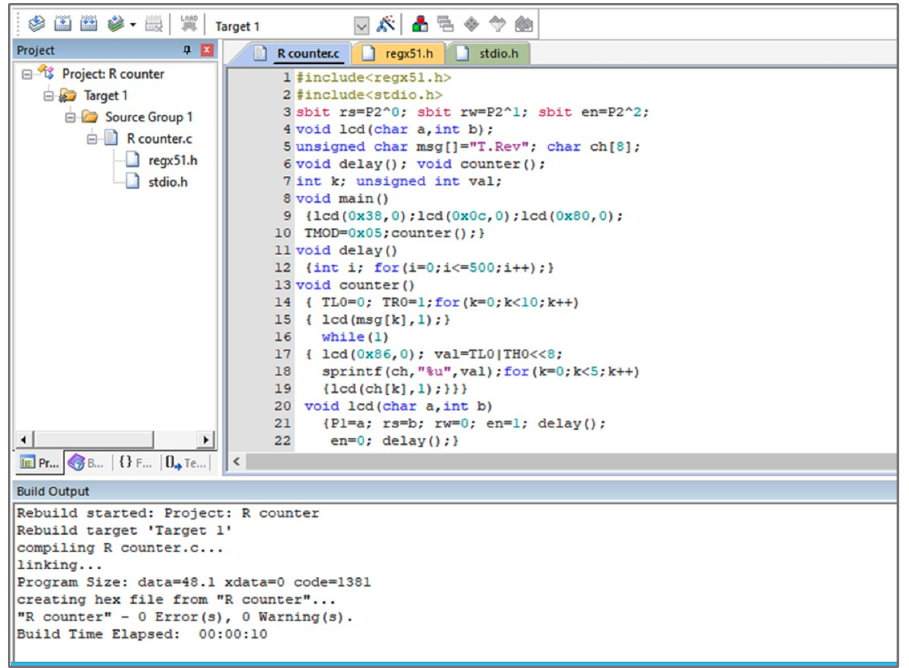
Figure 6. Programming code of the AT89C52 microcontroller using Keil μ Vision to display the signal numbers in the Liquid crystal display (LCD).